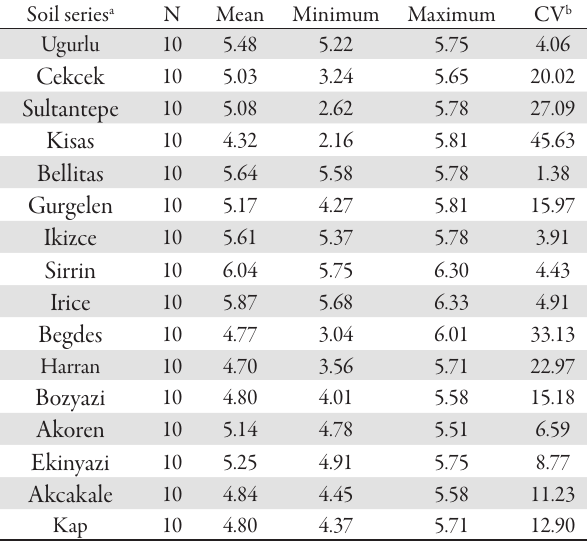
Tab. 6. C:N ratios of Harran plain soils (kg m -2 ) c